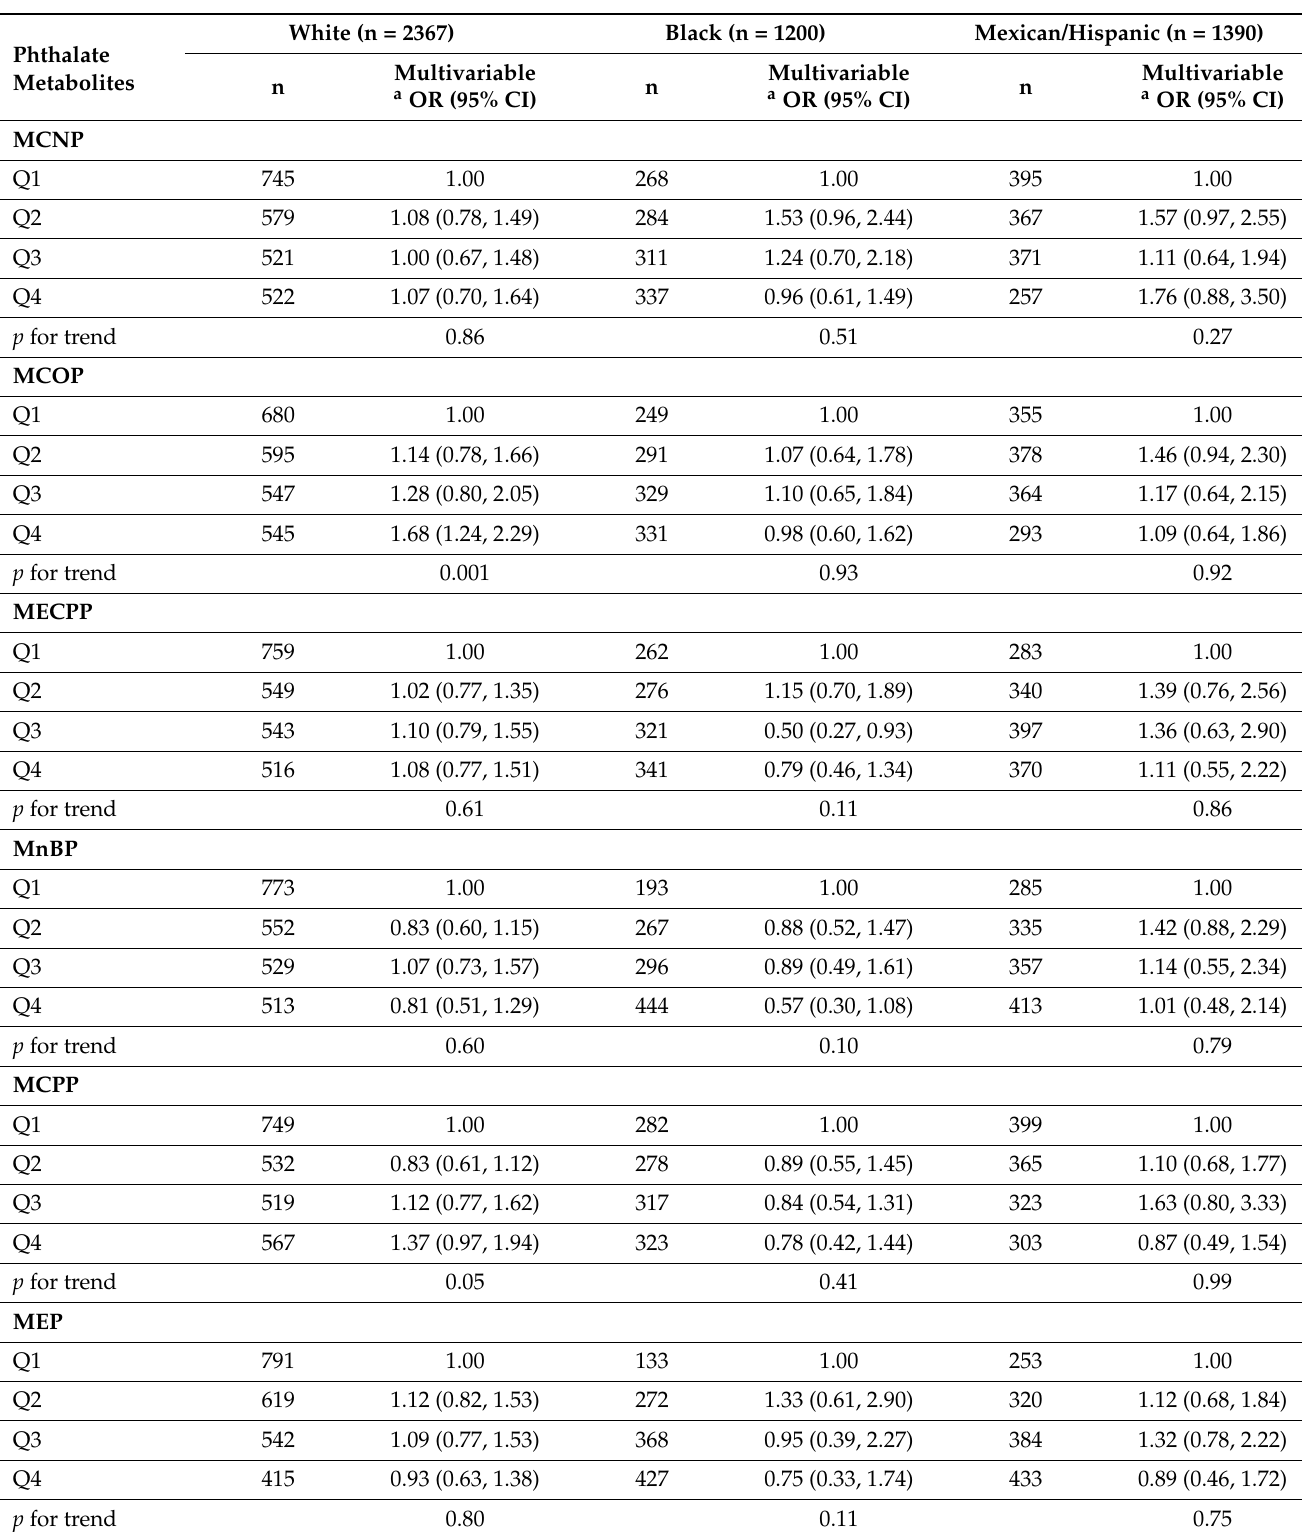
Table 5. Associations between urinary phthalate metabolite concentrations and metabolic syndrome among women by race, NHANES